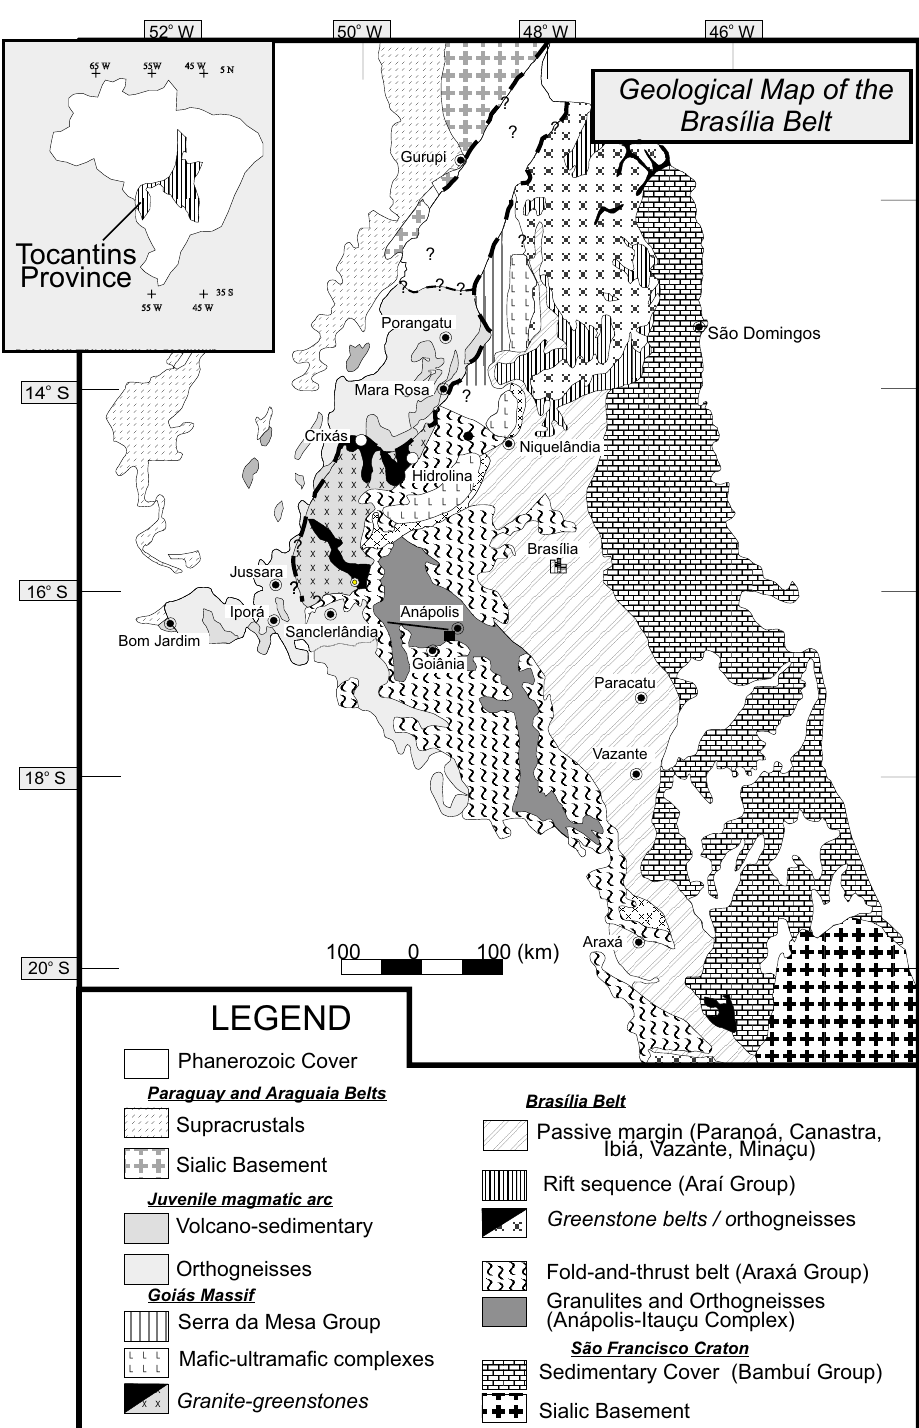
Fig. 1 – Tectonic sketch map of the southeastern part of the Tocantins Province (Brasília Belt).